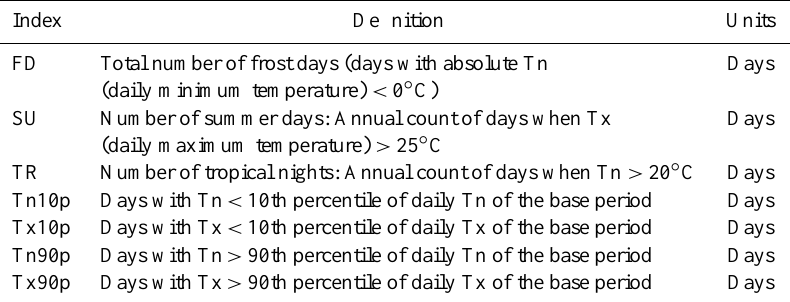
Table 2. Definitions and abbreviations of the ETCCDI temperature indices used in this study.